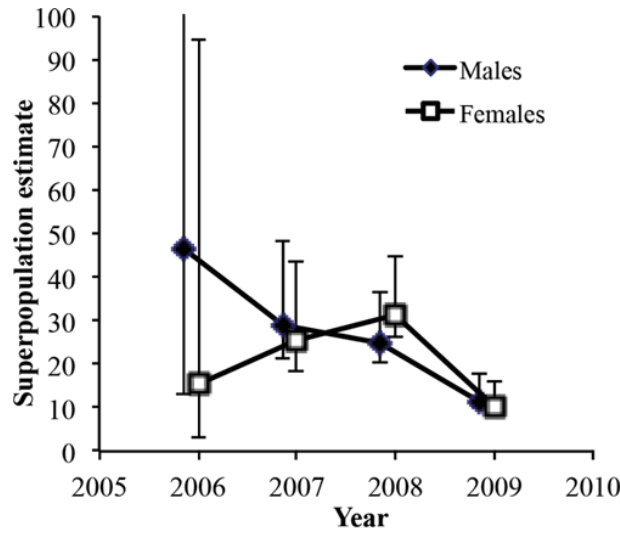
Fig. 4 . Trends in superpopulation estimates for male and female grizzly bears ( Ursus arctos horribilis ) for the Koeye River, Heiltsuk Territory (British Columbia, Canada) 2006-2009. The upper confidence limit for the male superpopulation estimate in 2006 was 189 (not shown). Points are staggered to ease interpretation of confidence limits.